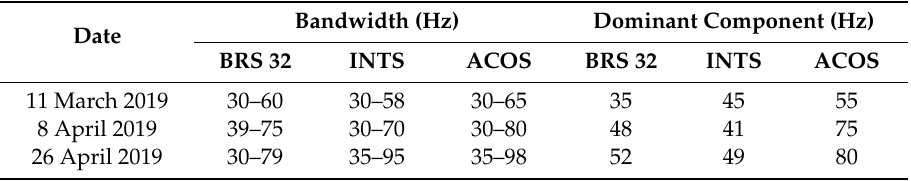
Table 1. Summarization of the frequencies obtained from the three